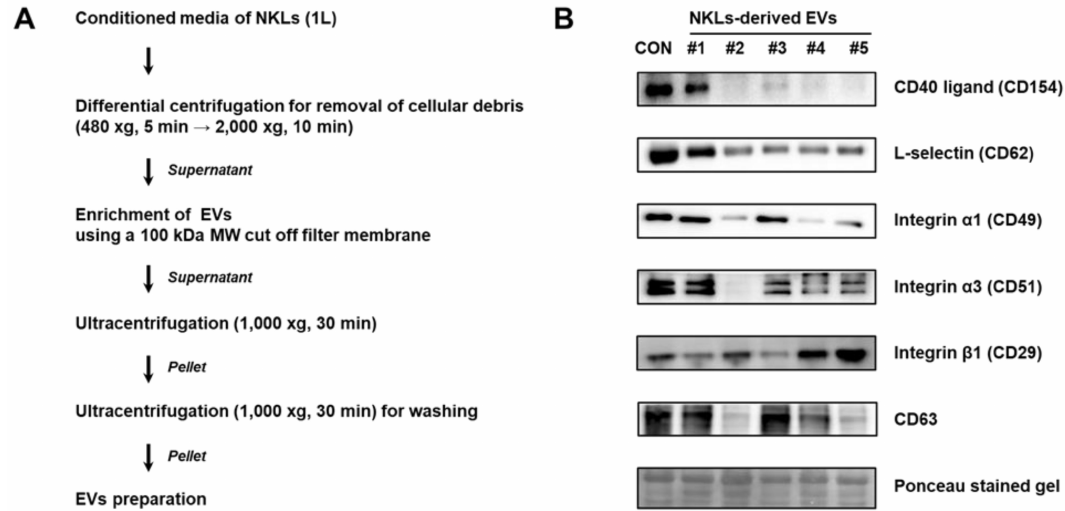
Figure 2. ( A ) Experimental scheme for extracellular vesicle (EV) isolation from conditioned medium of NKLs ( B ) Expression of markers in isolated EVs. Control EVs (CON) were prepared from concentrated medium containing pooled autologous plasma of 5